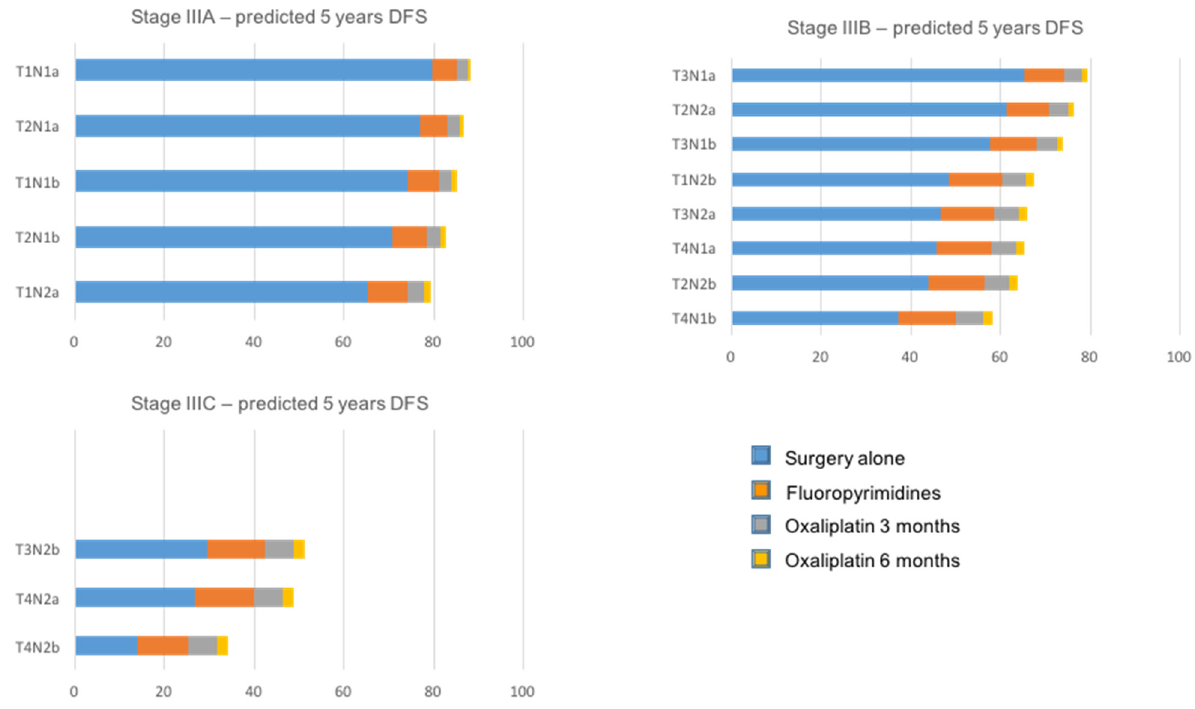
Figure 2. Prognostic subgroups within stage III colon cancers by therapeutic options: surgery alone; fluoropyrimidine alone; oxaliplatin-based doublet for 3 months; oxaliplatin-based doublet for 6 months.